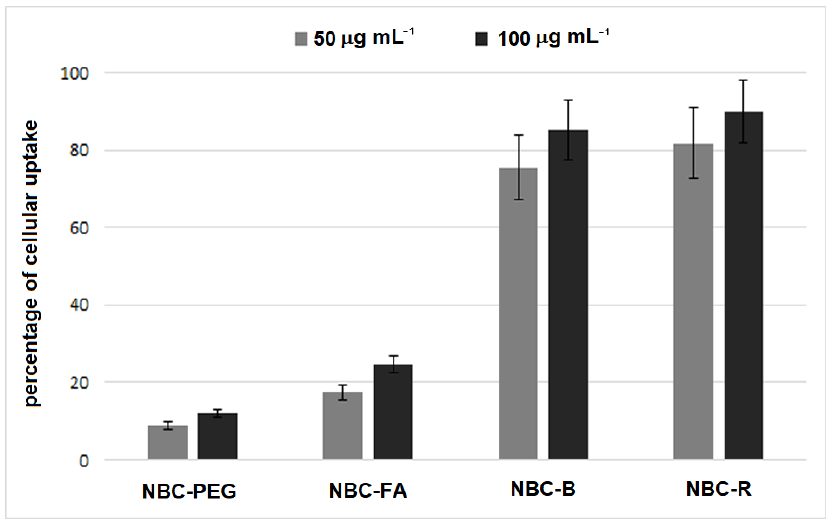
Figure 8. Percentages of cellular uptake in A549 cancer cell line of NBC-PEG, NBC-FA, NBC-B and NBC-R at the concentrations of 50 and 100 µ g mL − 1 . The percentages were calculated with respect to the total emission values (i.e., those recorded before the medium was removed and the monolayers were washed to eliminate the non-internalized NBC-TL). Each value represents the mean (±SD) of the experiments performed in triplicate.